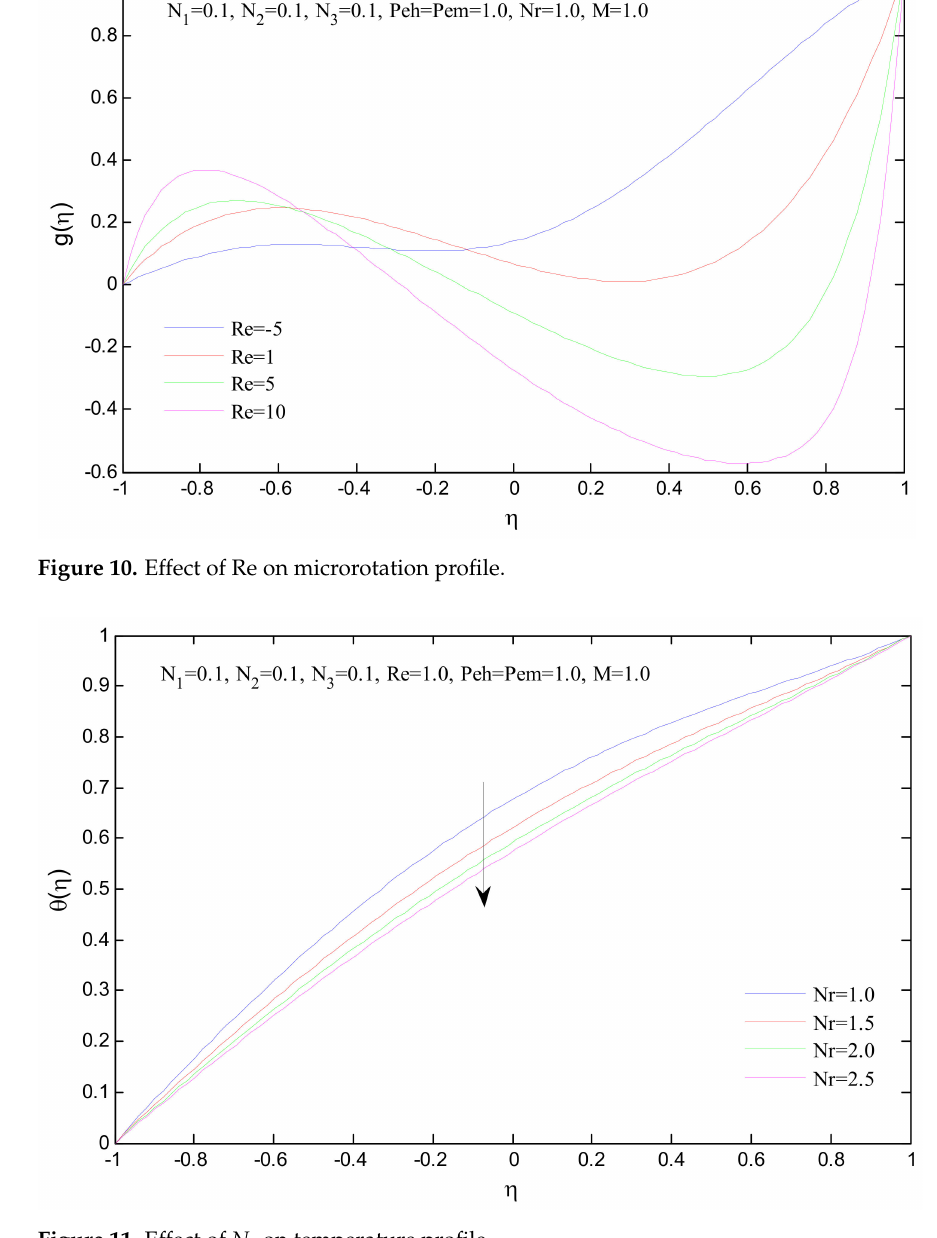
Figure 11. Effect of N r on temperature